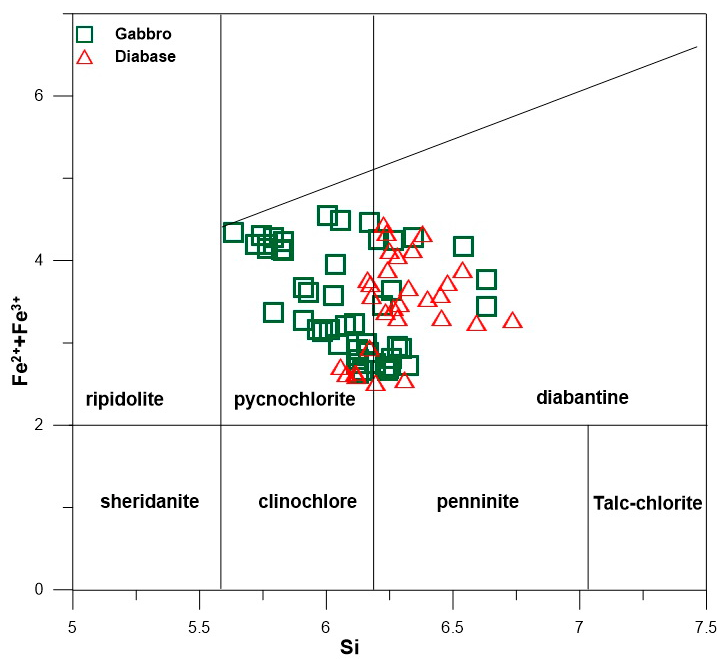
Figure 6. Plots of analyzed chlorite on their classification diagram of the examined mafic rocks according to Bailey [26].